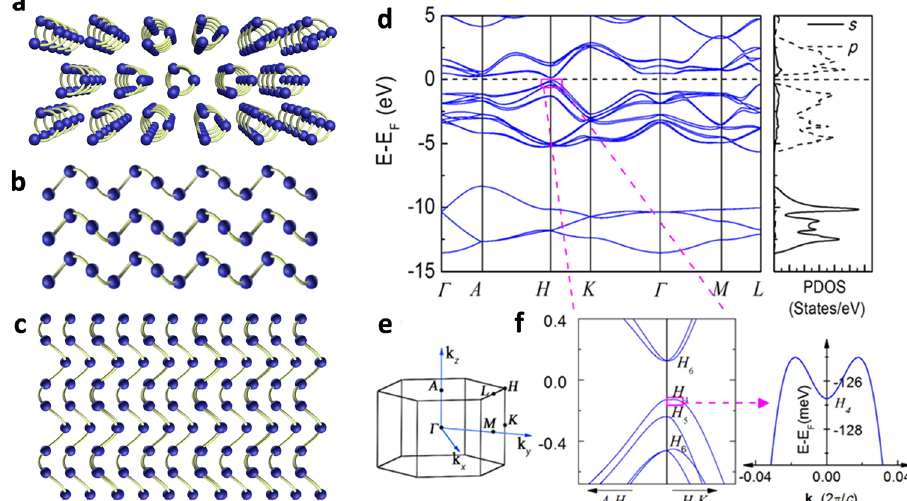
Fig. 1 Crystal structure and band structure of 2D tellurium. a The trigonal Te crystal structure consists of spiral chains with three-fold screw symmetry held together by inter-chain van der Waals bonds. The atomic chains can be arranged into 2D fi lms. b Side view and ( c ) top view of 2D Te fi lms. d Calculated band structure of Te including SOC and corresponding partial density of states (PDOS) with contributions from 5 s - and 5 p -orbital electrons. e First Brillouin zone of Te. f Left panel: Zoomed-in band features near the direct band edge at the H point. Right panel: Camel back humps in the vicinity of the valence band edge. d – f are reproduced from ref. 88